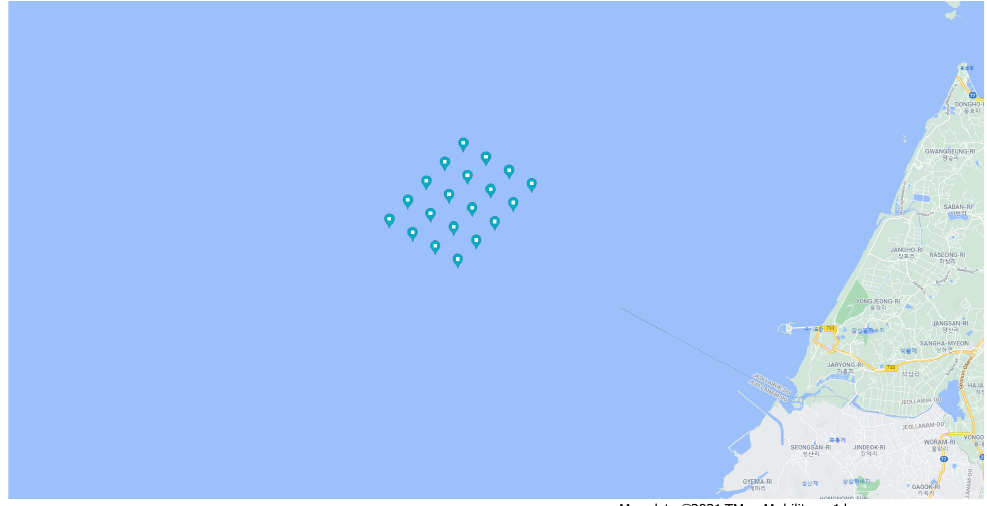
Figure 4. Offshore wind farm: Google Maps site view.